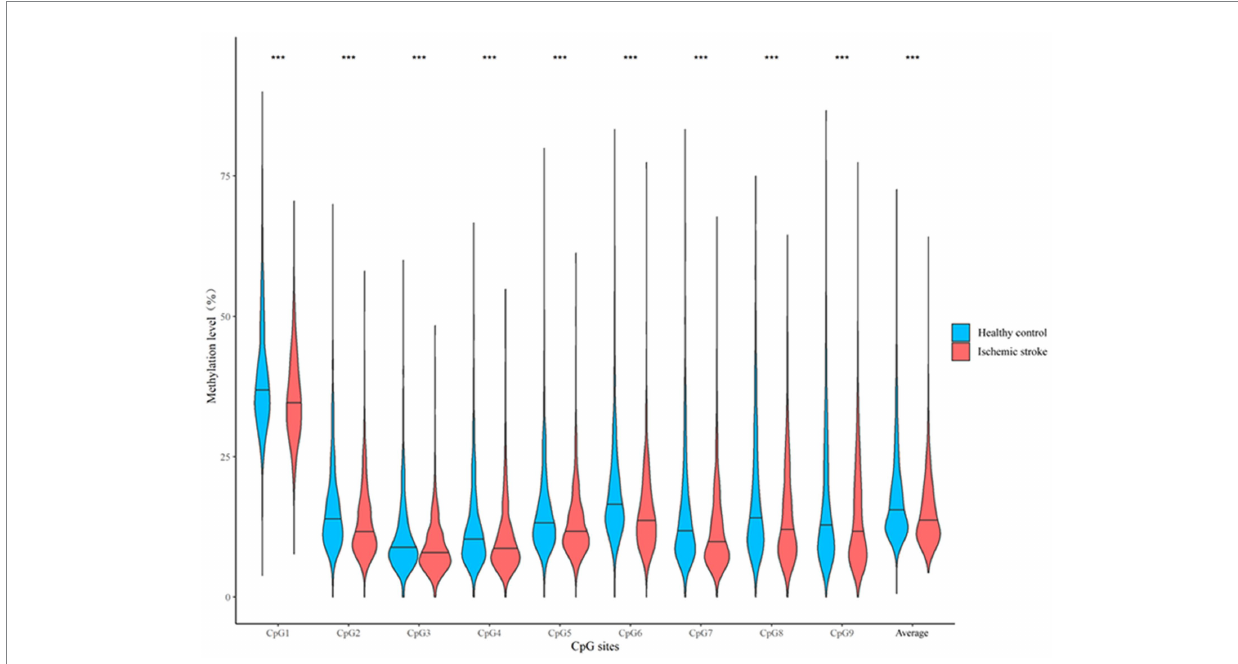
FIGURE 3 A box plot showing the individual and average DNA methylation levels of CpG sites in the CORIN promoter region according to the status of ischemic stroke in the discovery sample. *** p <